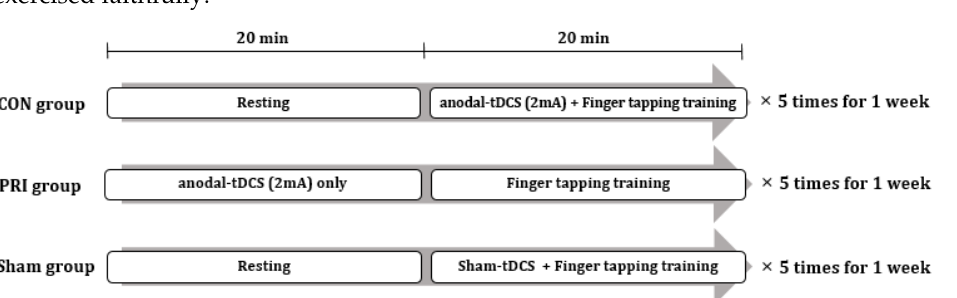
Figure 1. Experimental design involving the three intervention groups. tDCS: anodal transcranial direct current stimulation.